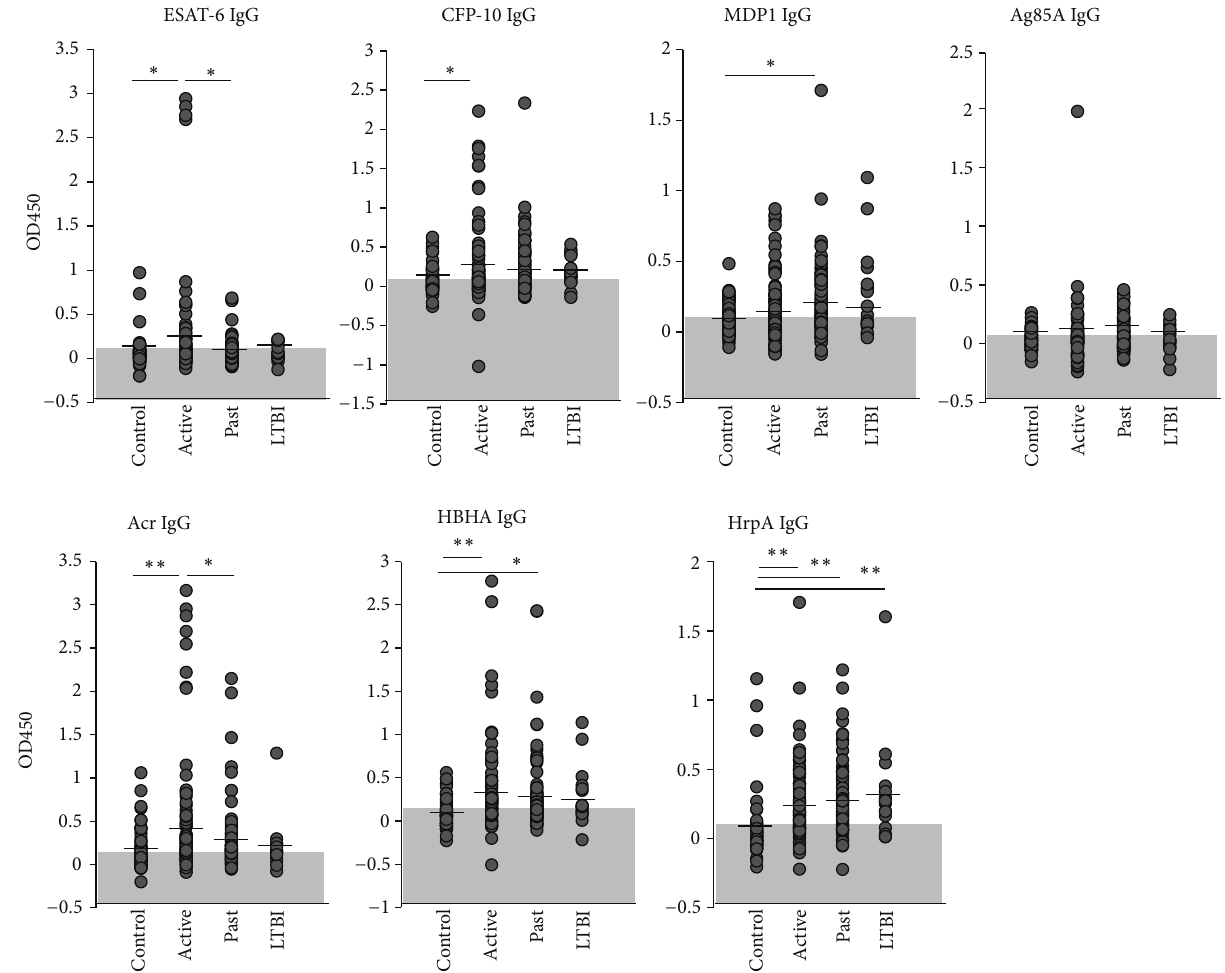
Figure 1: IgG responses to Mtb antigens. The levels of serum IgG against 7 antigens (ESAT-6, CFP-10, MDP1, Ag85A, Acr, HBHA, and HrpA) in active disease (labeled as “Active”), past disease (“Past”), latent TB infection (“LTBI”), and controls (“Control”) were analyzed by ELISA. Data shown are the average of triplicate experiments. Shaded areas: areas under cut-off values, vertical lines: mean values, ∗ 𝑃 < 0.05 , ∗∗ 𝑃 < 0.01